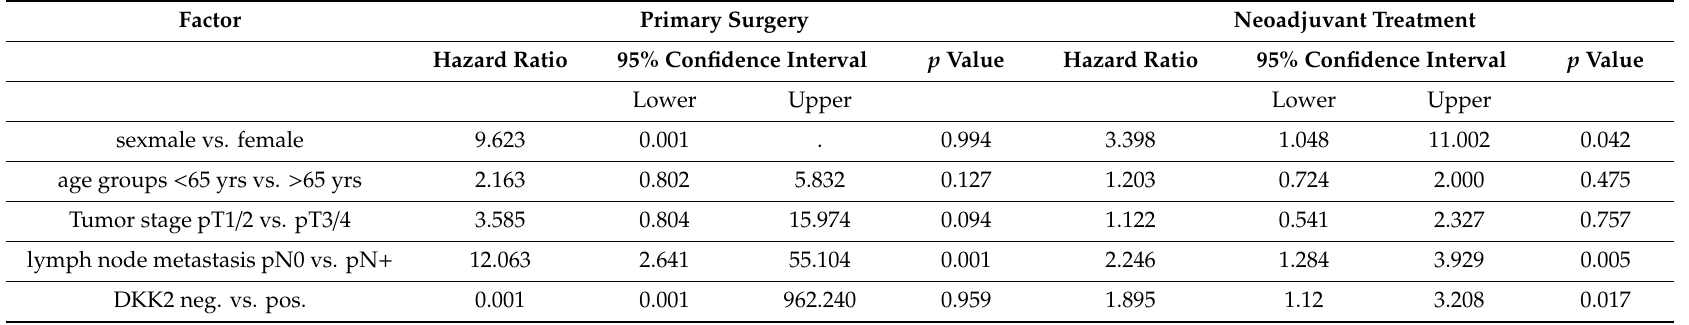
Table 2. Multivariate cox-regression analysis for patients after primary surgery and neoadjuvant treatment.